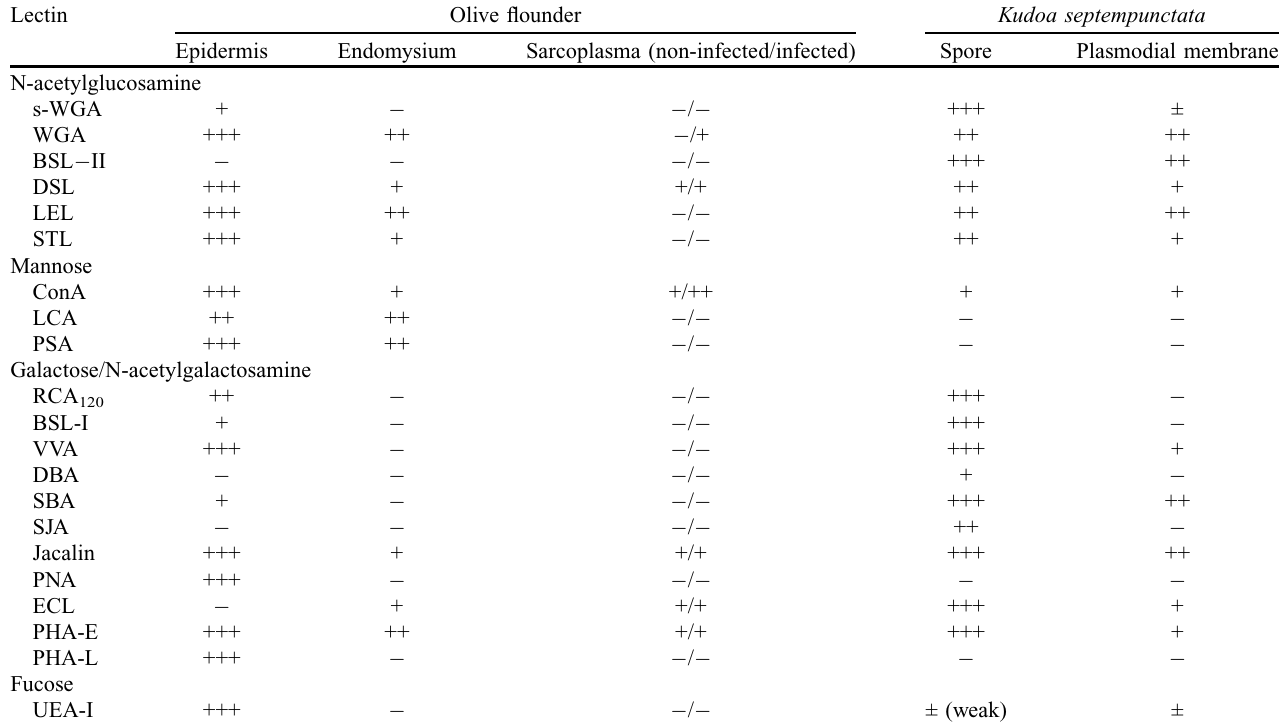
Table 2. Lectin binding patterns of spores in the muscles of olive flounder infected by Kudoa septempunctata . Lectin Olive